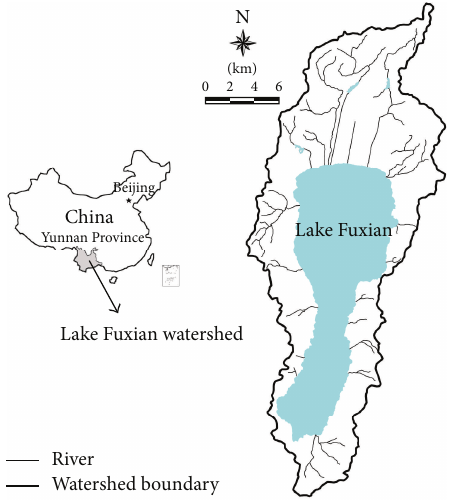
Figure 1: Location of Lake Fuxian